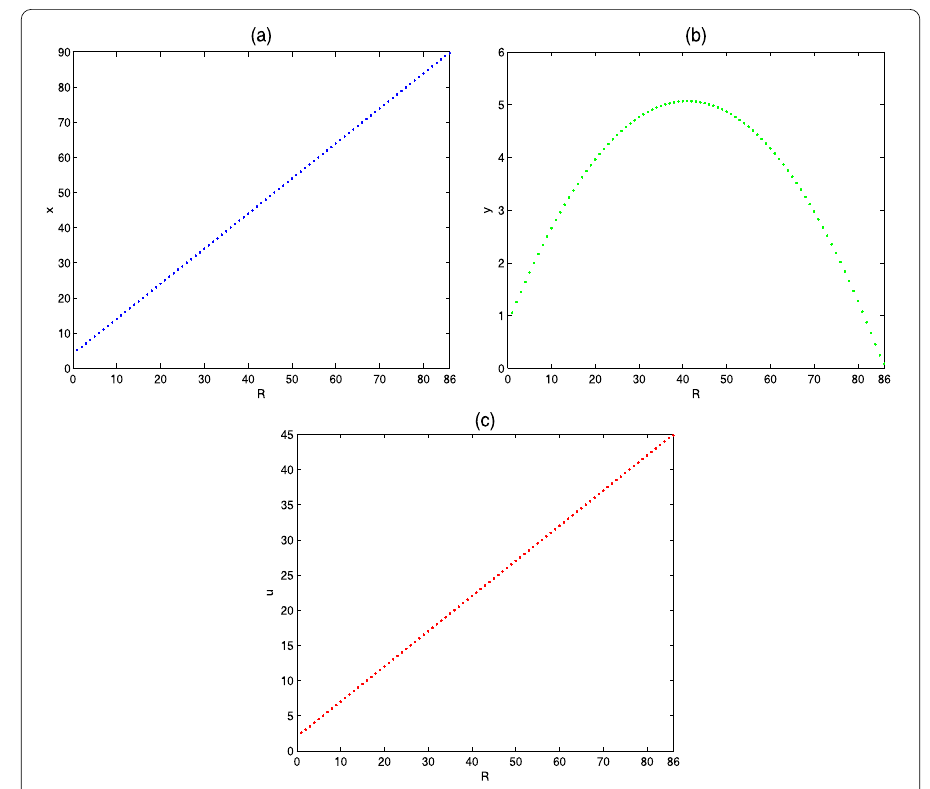
Figure 6 Impact of prey refuge R on system (3) with ( x 0 , y 0 , u 0 ) =